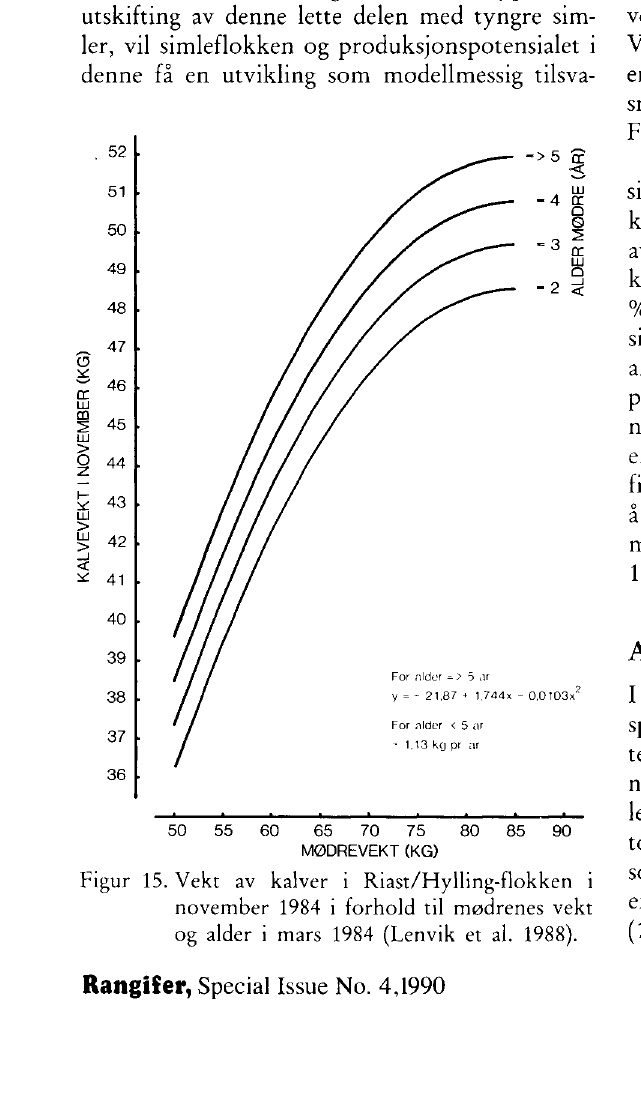
Figur 15. Vekt av kalver i Riast/Hylling-flokken